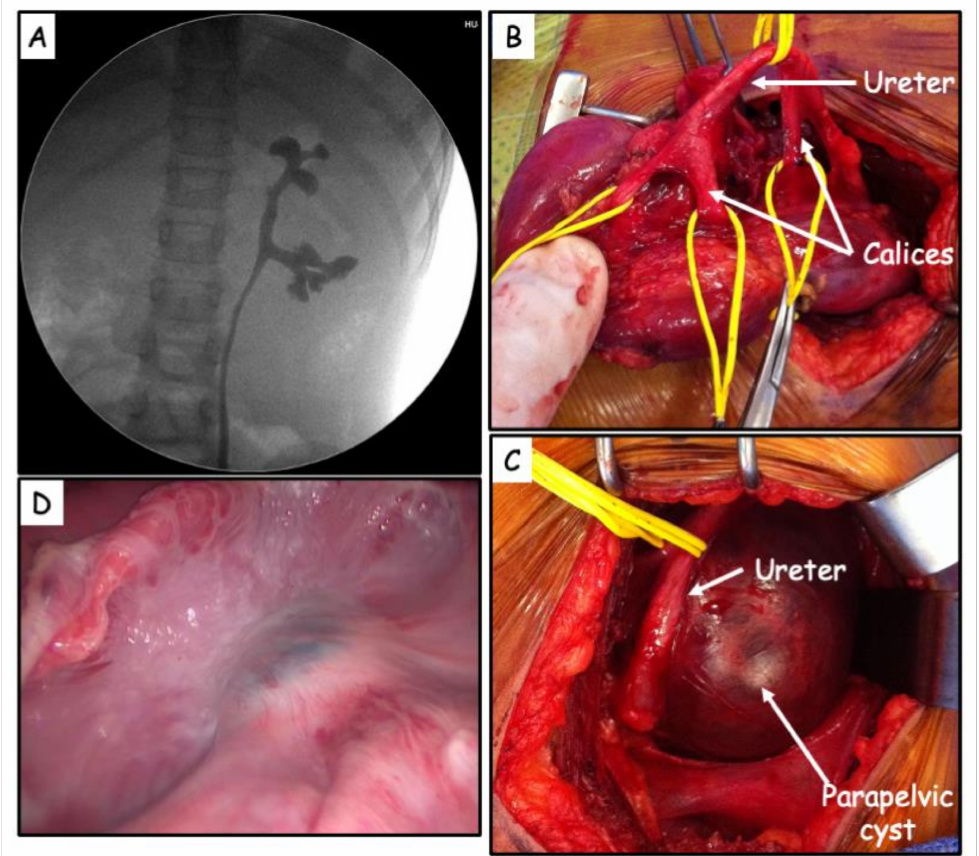
Figure 2. ( A ) Absence of renal pelvis demonstrated on retrograde pyelography. ( B ) Renal anatomy after subtotal excision of the cyst. No identifiable renal pelvis. Calyces communicating directly with the proximal ureter. ( C ) Large parapelvic cyst causing compression. ( D ) Intraoperative retrograde pyelography with methylene blue (visible in transparency in a renal calyx in the center of the photo). No communication was identified between the unroofed cyst and the renal